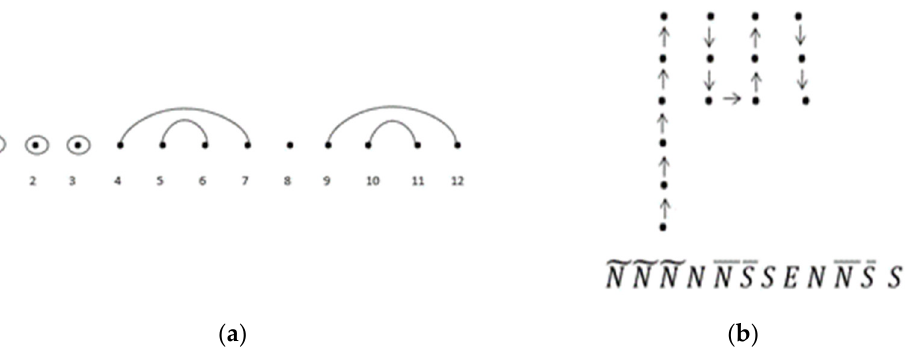
Figure 15. ( a ) One representation of r 2307 ( 12, 3 ) ; ( b ) corresponding modified unit-step NSE** lattice walk with a length of 12, a height of three, and consecutive north and south steps.